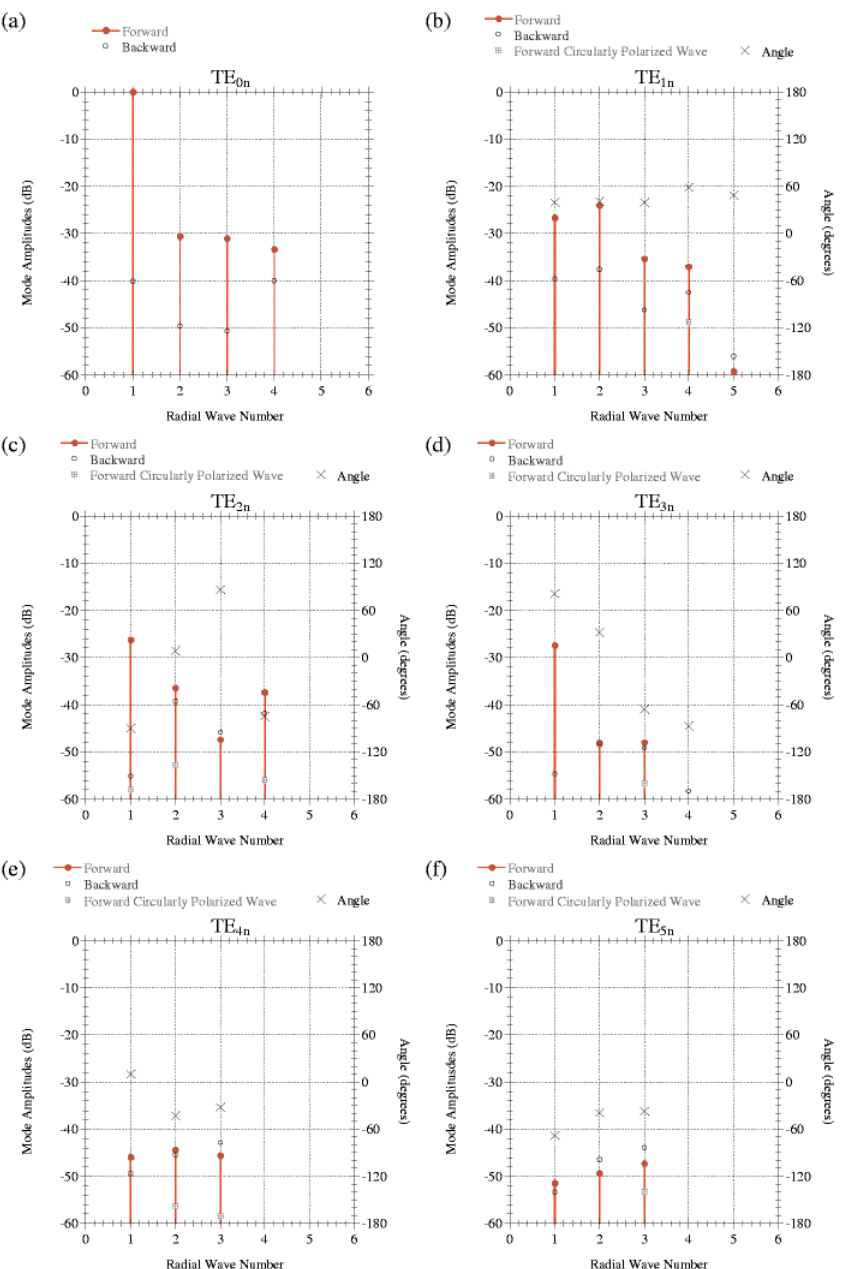
FIG. 26. (Color) The mode spectrum after the transport line when the injected signal is the TE 01